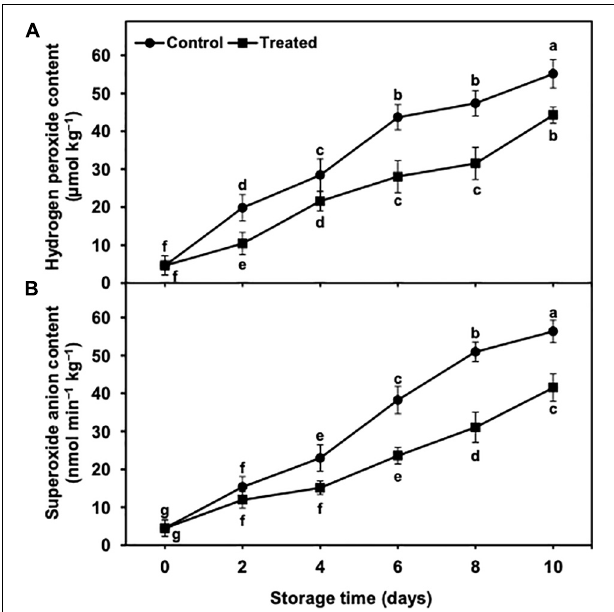
FIGURE 5 | Effect of hydrogen sulfide on hydrogen peroxide content (A) and superoxide anion content (B) in peel of banana fruit. Data are mean of three replications and vertical bars show standard of the means. Different letters show significant difference according to least significant difference